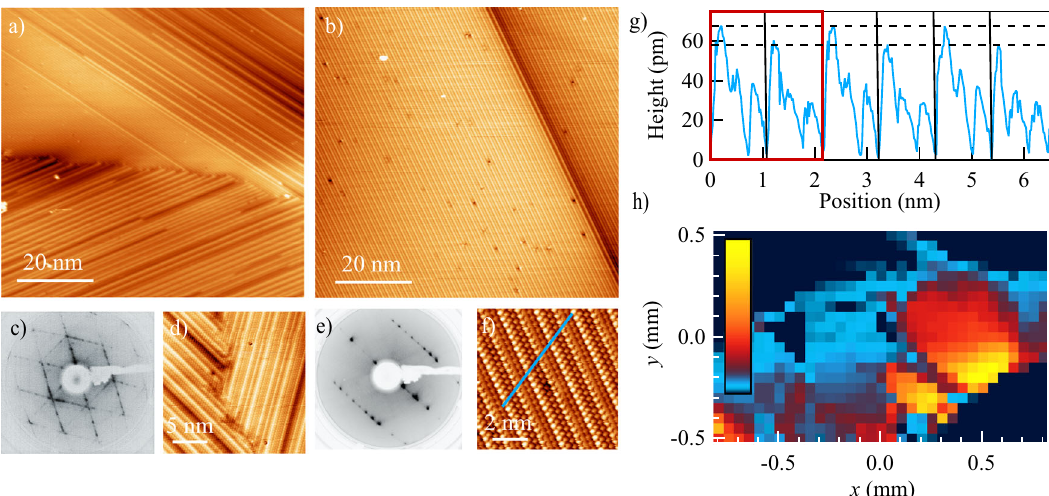
Fig. 2 Real-space view of the strain-induced 6 × 1 phase. a , b Large scale STM images of an ( a ) unstrained and ( b ) strained sample at 4.5 K. A characterization of the strained sample at various points across the surface is shown in Supplementary Fig. S3. c , e LEED images of ( c ) unstrained ( E = 85 eV) and ( e ) strained samples ( E = 60 eV) at T = 30 K. A single rotational domain and 6 × 1 periodicity are observed in the LEED pattern of the strained sample. d , f Atomic resolution STM images of the large scale images from ( a ) and ( b ). The line cut marked in ( f ) is presented in ( g ) and reveals the 6× periodicity (red box) of the phase. Black vertical lines highlight inequivalent blocks of three atoms, which are differentiated by their respective heights (horizontal dashed lines). h Real-space ARPES intensity map ( h ν = 6.3 eV, T = 30 K) of a strained sample revealing strain-induced effects on the millimeter scale. The corresponding ARPES spectra obtained with a microfocused laser is shown in Supplementary Fig. S4.